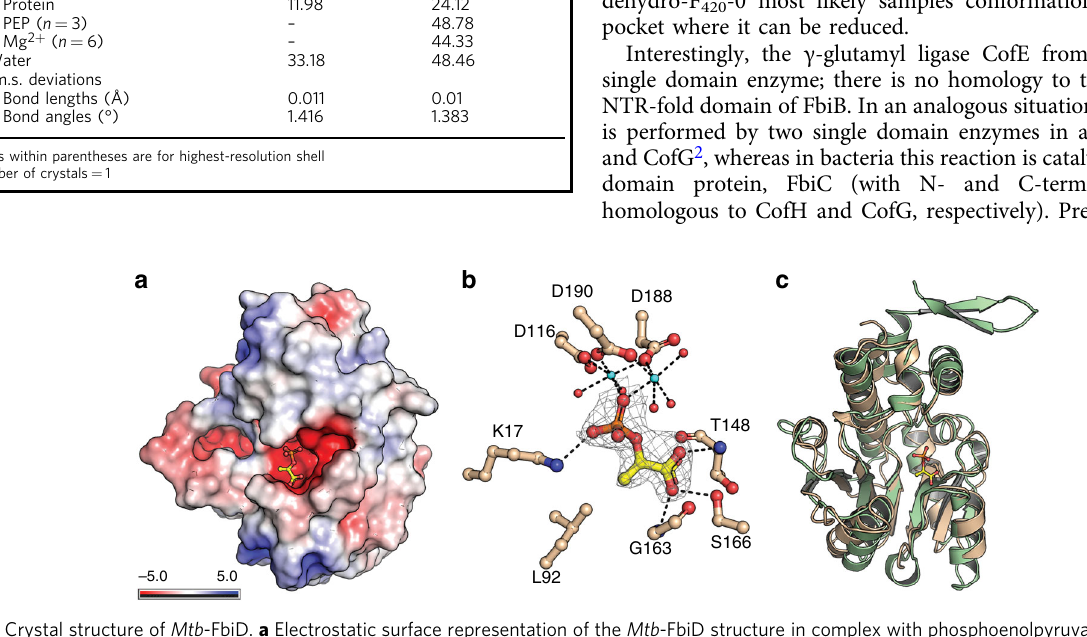
Fig. 3 Crystal structure of Mtb -FbiD. a Electrostatic surface representation of the Mtb -FbiD structure in complex with phosphoenolpyruvate (PEP), shown as a ball-and-stick model. b The phosphate group of PEP binds to three aspartic acid side chains through two Mg 2 + ions (shown in cyan). PEP is shown in 2 F o − F c omit density contoured at 2.0 σ , and drawn as ball-and-stick model. Water molecules are shown as red spheres and hydrogen bond interactions are outlined as dashed lines. c Superposition of Mtb -FbiD (wheat ribbon) and Methanocaldococcus jannaschii ( Mj -CofC) (green ribbon), indicating 1.85 Å root mean square difference (rmsd) over 181 superimposed C α . PEP is shown as a ball-and-stick